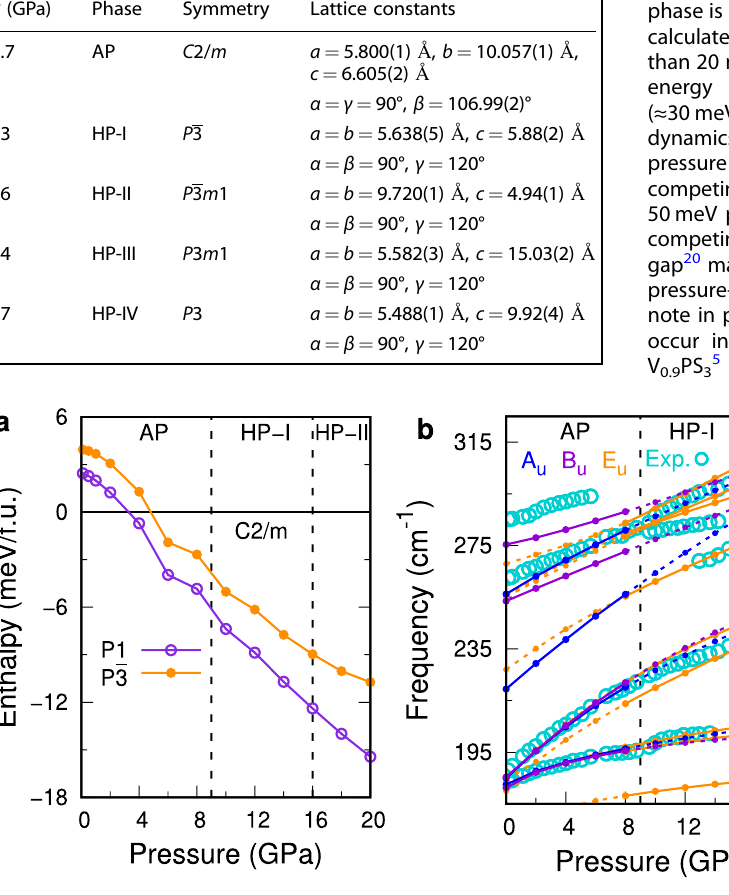
Fig. 4 Computed enthalpies and infrared/Raman frequencies versus pressure. a Relative enthalpies of the P 3 and P 1 phases with respect to C 2/ m . b, c Comparison between frequencies of computed and experimental b infrared and c Raman modes. For clarity, A u/g (blue) and B u/g (violet) modes from the C 2/ m phase and E u/g (orange) modes from the P 3 phase are selected for display. The experimental frequencies are overlaid in open circles (cyan). The experimental frequencies were shifted from the theoretical data by 5 and 8 cm − 1 in panels b and c , respectively, to overlap the theoretical curves. Frequencies from the C 2/ m ( P 3 ) phase are depicted as solid (dashed) lines below 8 GPa and dashed (solid) lines above 8 GPa.